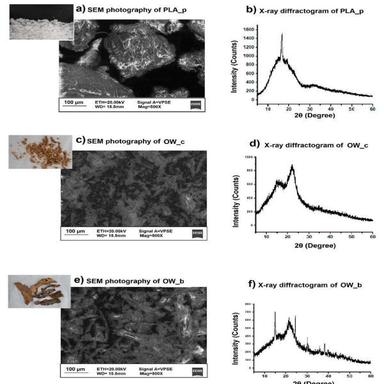
PLA pellet, SEM photography with 500x magnification (a), X-ray diffractogram (b) of pure PLA (PLA_p); OW_c sample, SEM photography with 500x magnification (c), X-ray diffractogram (d) of pure olive wood chip powder (OW_c); OW_b sample, SEM photography with 500x magnification (e), X-ray diffractogram (f) of olive wood bark powder (OW_b).